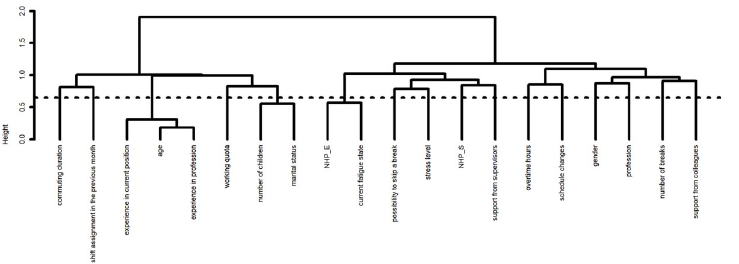
Fig 1. Dendrogram of the hierarchy of the 20 variables at individual-level. Dotted line depicts the best cut-off of clusters according to the bootstrap approach.